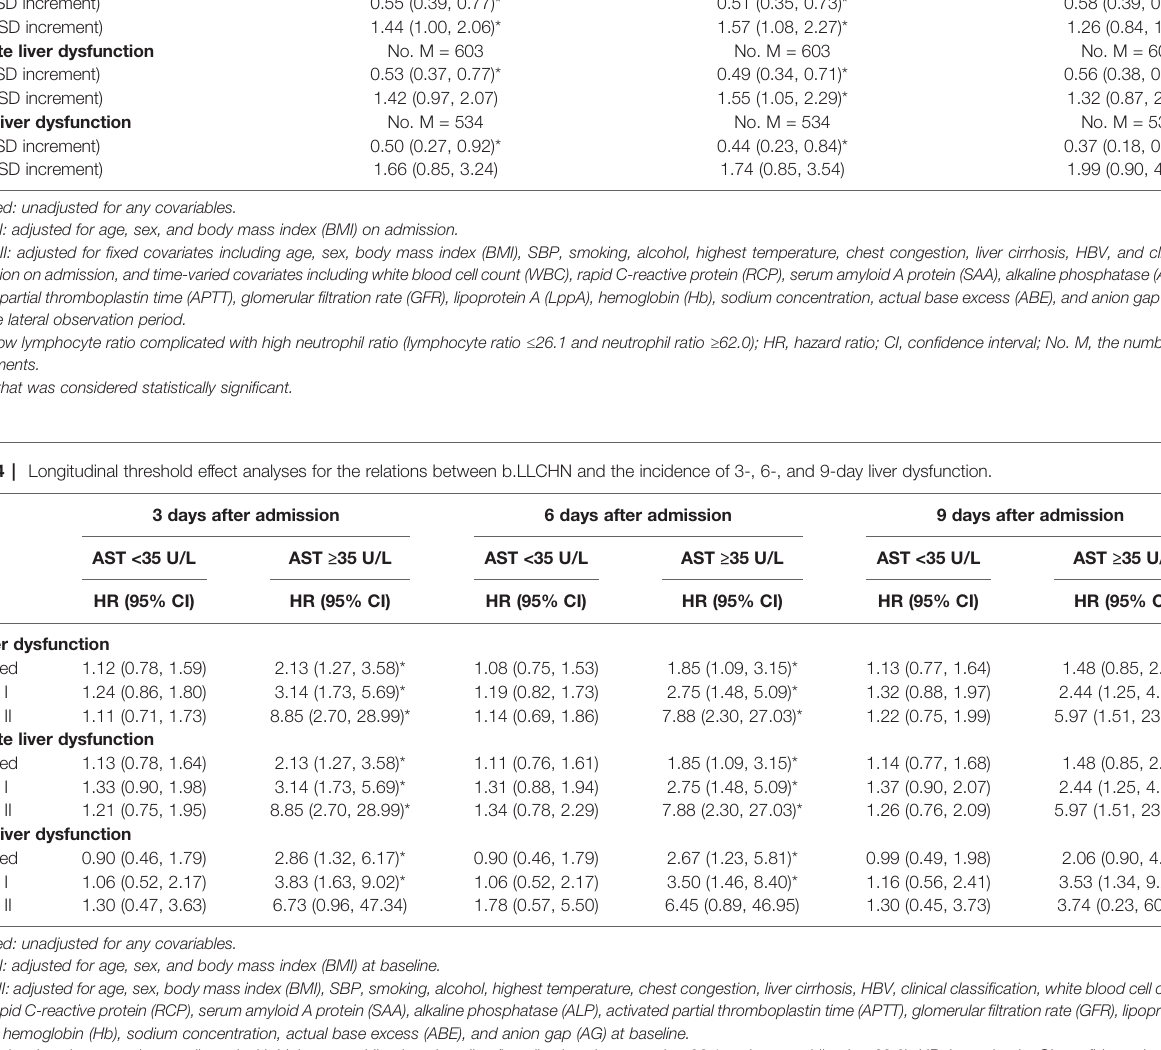
TABLE 3 | Lateral associations of the incidence of liver dysfunction events with per-SD increment in lymphocyte ratio or neutrophil ratio in the LLCHN group. Unadjusted Adjusted I Adjusted II HR (95% CI) Mild liver dysfunction